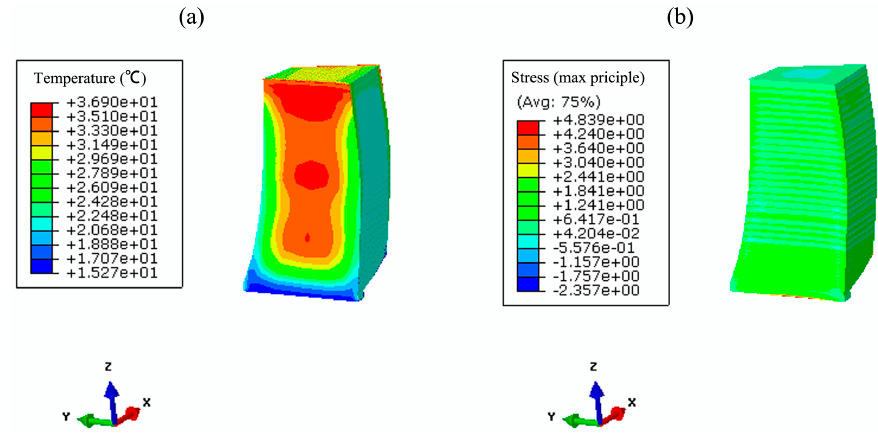
Figure 13. Conventional computations of the temperature and stress field on 5 June 2013. ( a ) temperature ( ˝ C); ( b ) first principle stress (MPa).